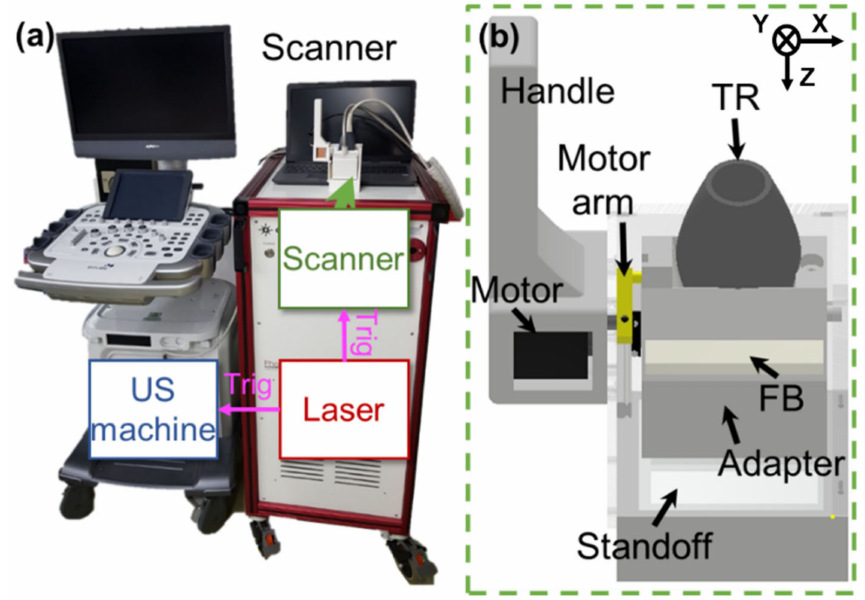
Figure 1. ( a ) Photograph of a clinical handheld PA/US imaging system and a 3D handheld imag- ing scanner. ( b ) Schematics of the 3D handheld scanner. PA: photoacoustic; US: ultrasound; TR: ultrasound transducer; and FB: fiber